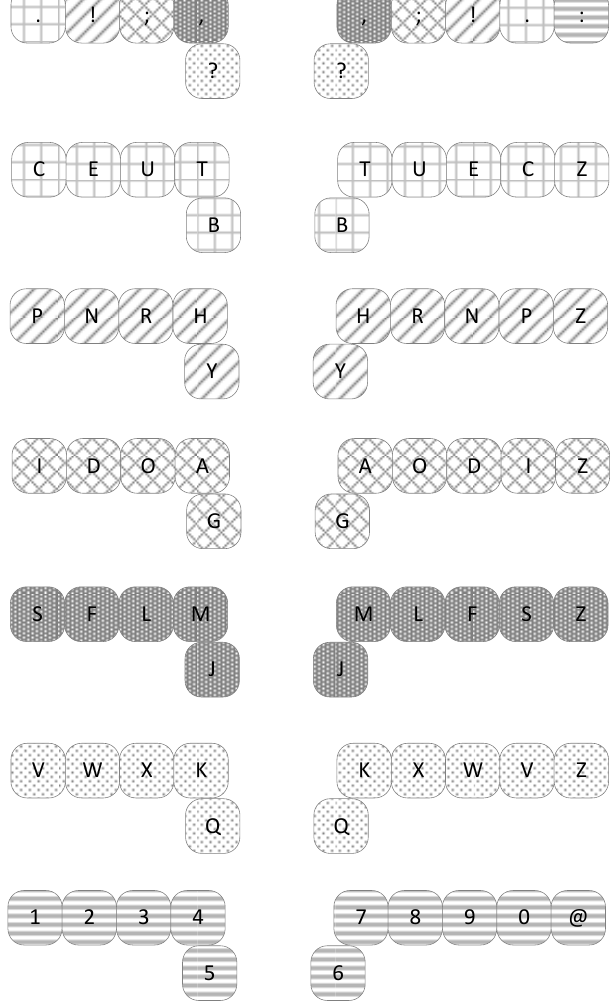
Figure 12. NUM-ORK+ arrangement.